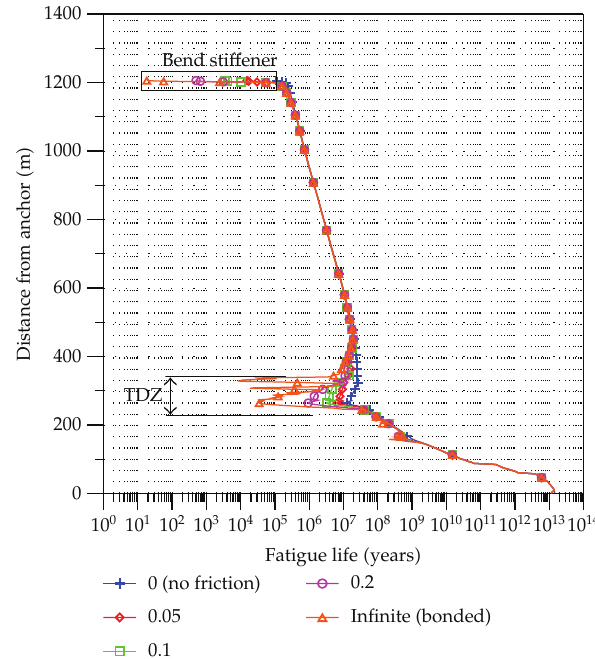
Figure 12: Fatigue life in the outer armor along the flexible pipe: e ff ect of di ff erent coe ffi cients of